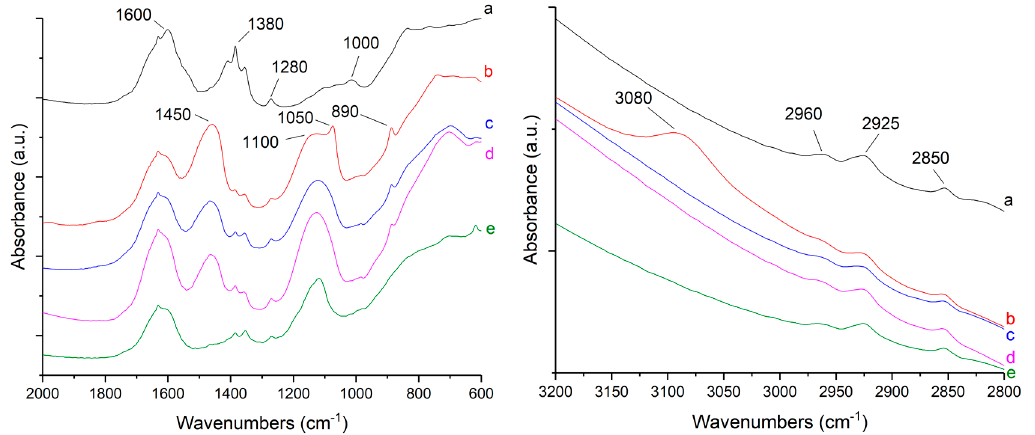
Figure 11. FT-IR spectra of CATs used for different years ( a ) as-prepared; ( b ) served for 1 year; ( c ) served for 2 years; ( d ) served for 3 years; ( e )served for 4 years.